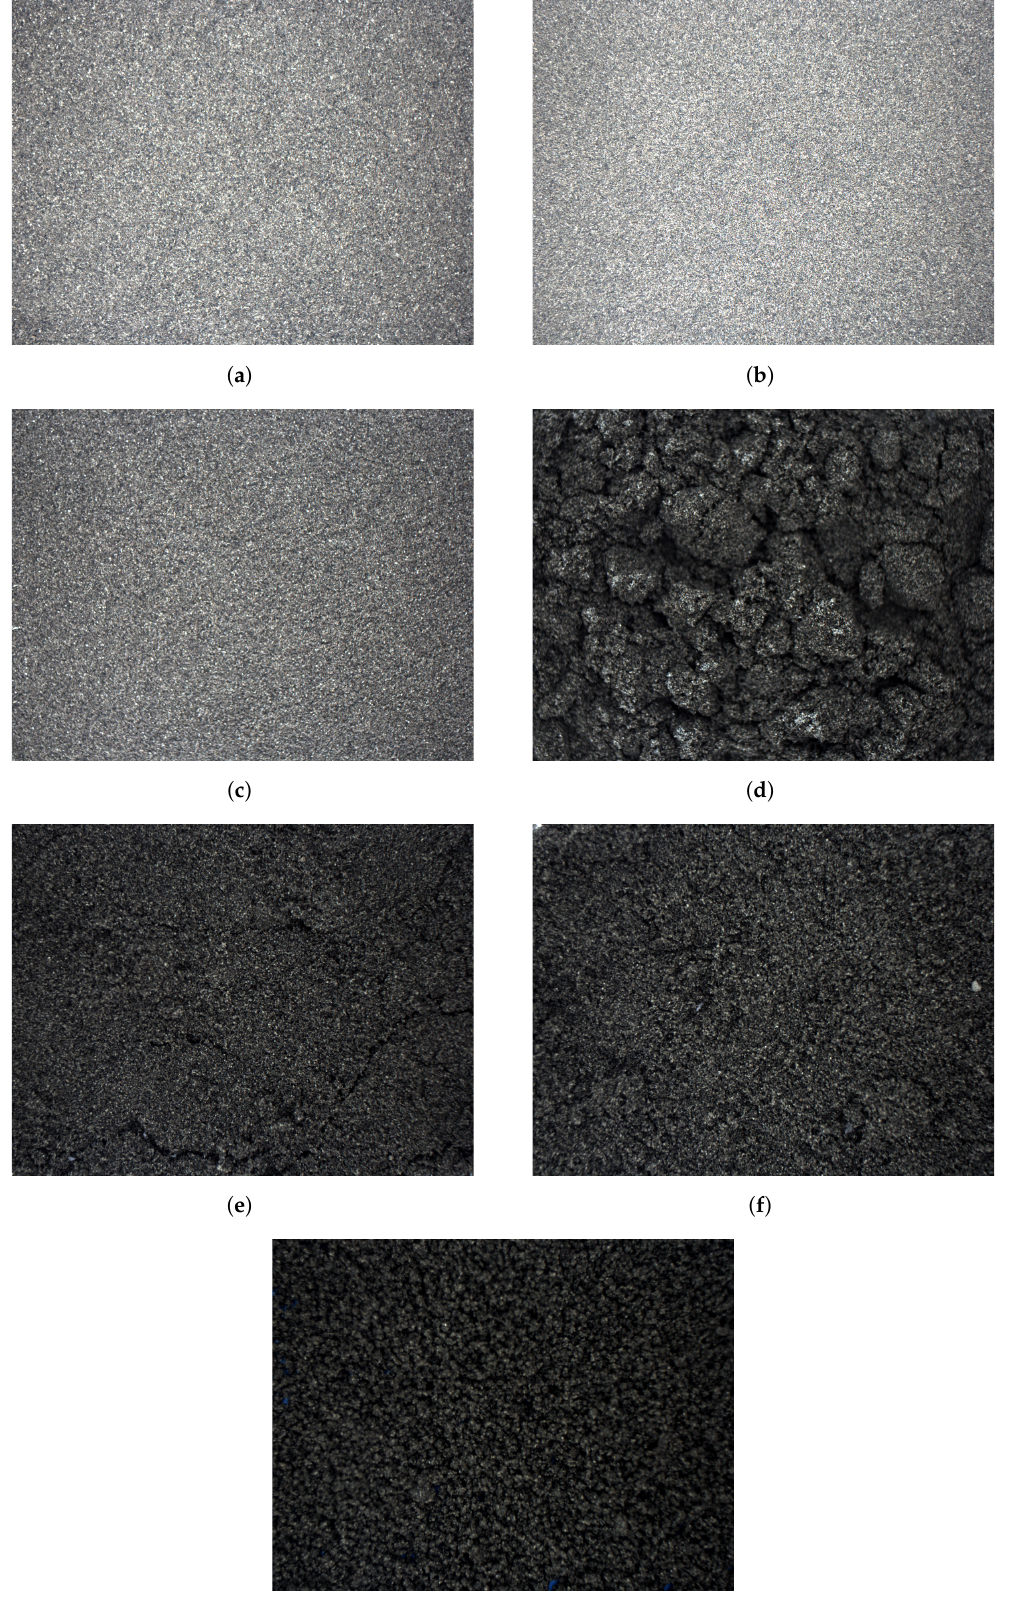
Figure 21. Images of 0.1–0.2 mm material sample with moisture contents of: ( a ) 0.5%, ( b ) 1%, ( c ) 3%, ( d ) 5%, ( e ) 7%, ( f ) 9%, and ( g )